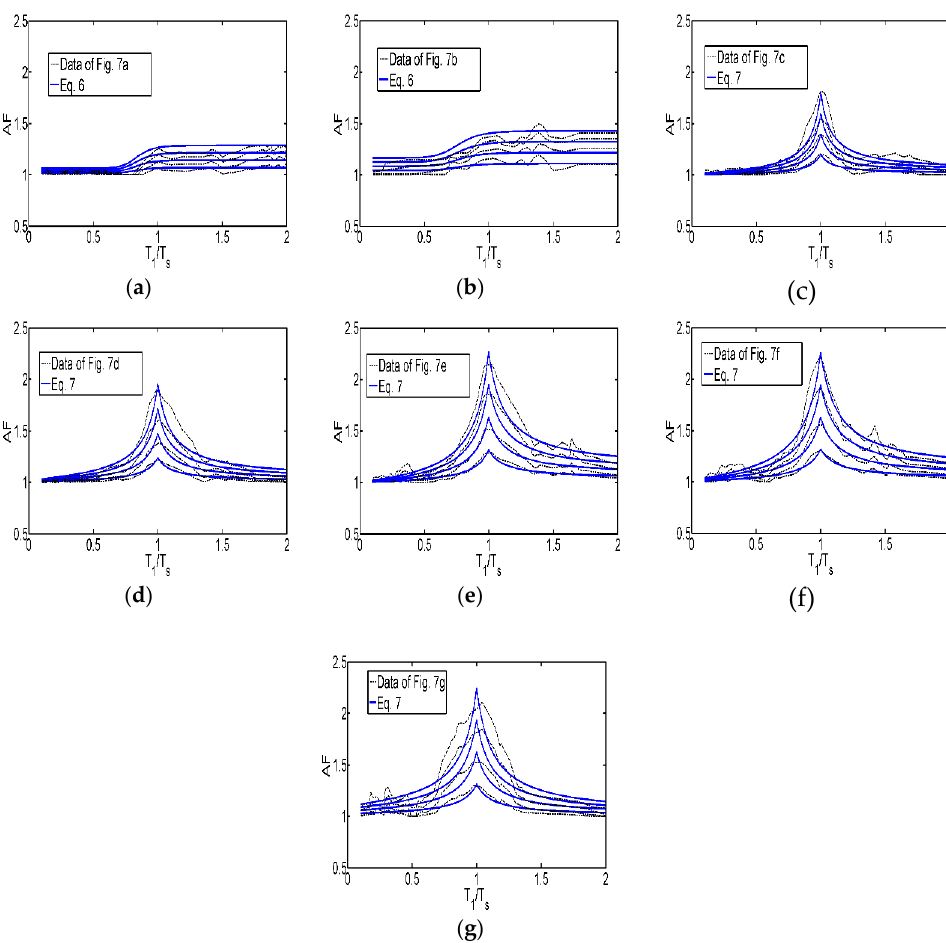
Figure 8. Comparison of the strength amplification factors (AF) obtained with Equations (6) and (7) with those presented in Figure 7, corresponding to a ductility demand µ = 2. ( a ) Zone A; ( b ) Zone B; ( c ) Zone C; ( d ) Zone D; ( e ) Zone E; ( f ) Zone F; ( g ) Zone G.